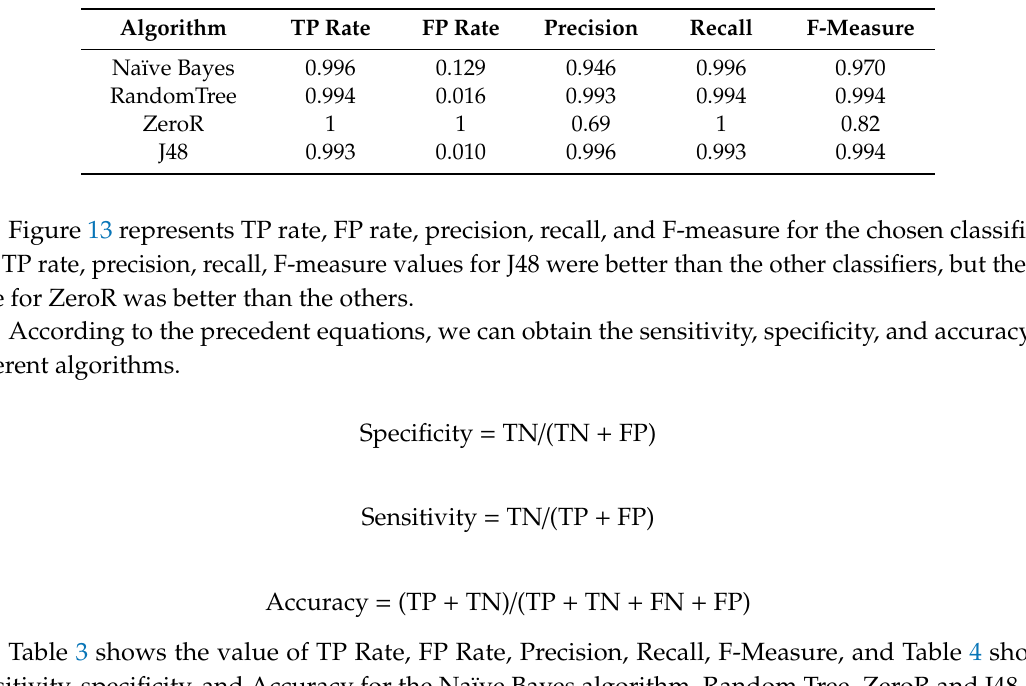
Table 3. Values of TP, FP, precision, recall, and F-measure for algorithms.